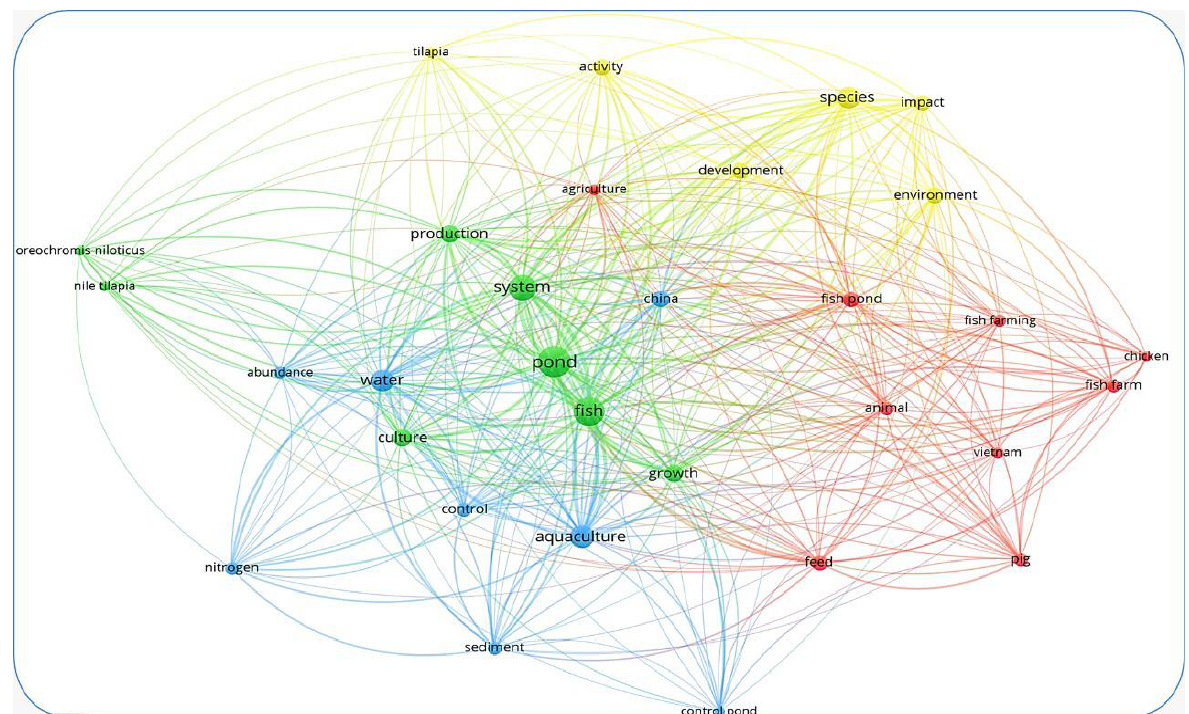
Figure 1. High- frequency words “fish pond integrated agriculture” in abstracts and title s of high- Figure 1. High-frequency words “fish pond integrated agriculture” in abstracts and titles of high- influence publications. influence